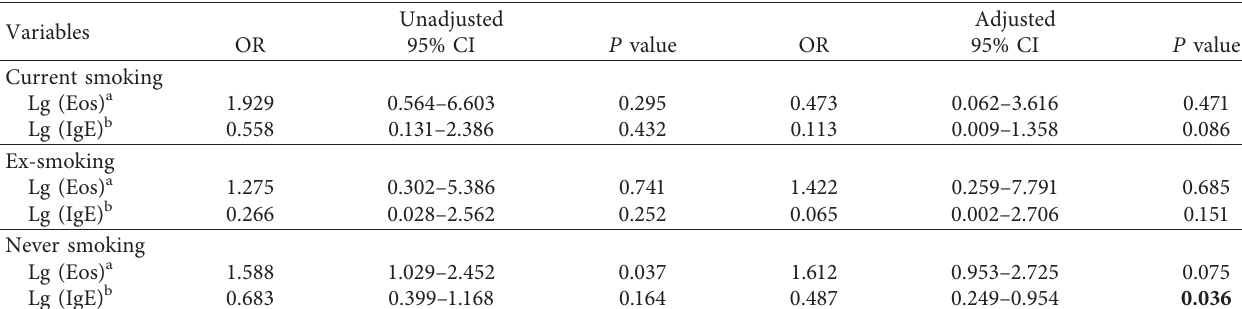
Table 4: Association between Th2 biomarkers and small airway obstruction by smoking